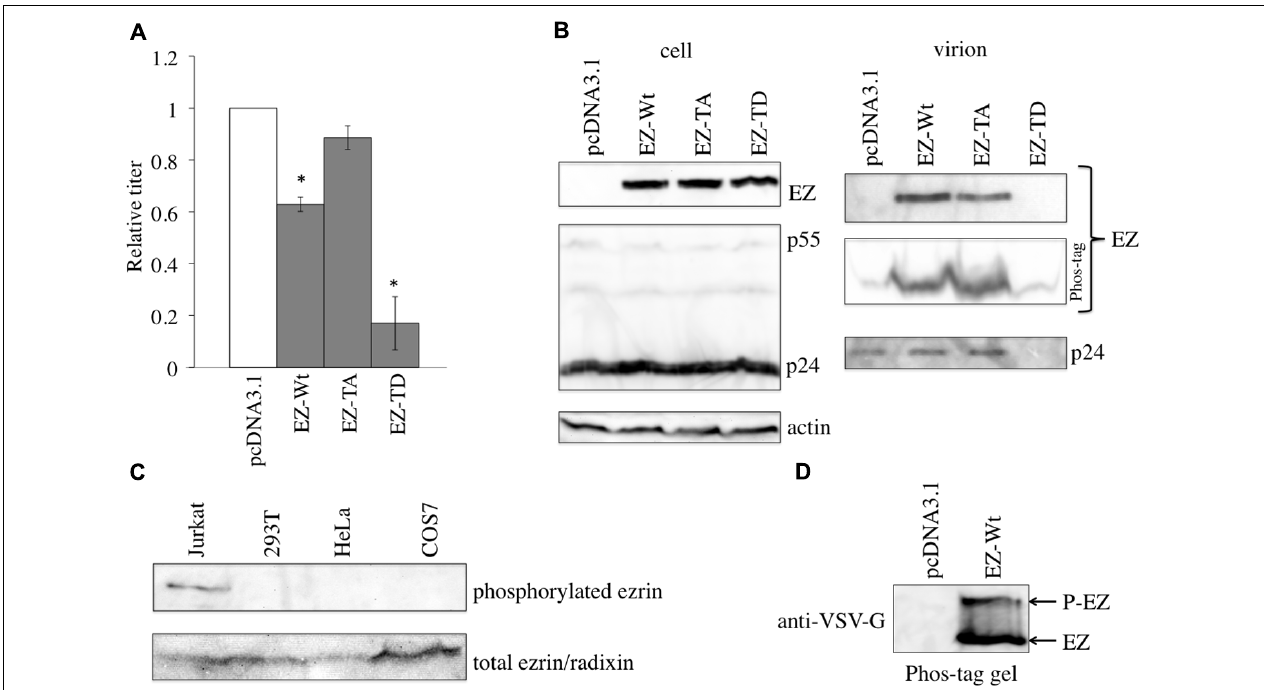
FIGURE 4 | EZ-TD inhibits HIV-1 vector release. (A) COS7 cells were transfected with the HIV-1 vector construction plasmids together with pcDNA3.1, EZ-Wt, EZ-TA, or EZ-TD expression plasmid, and culture supernatants from the transfected cells were inoculated onto HeLa/CD4 cells. Transduction titers of pcDNA3.1-transfected cells were always set to 1, and relative values of transduction titers of other transfected cells are indicated. Error bars show standard deviations, and asterisks indicate statistically significant differences compared to pcDNA3.1-transfected cells. (B) Cell lysates (left panels) and virion pellets of culture supernatants from the transfected cells (right panels) were analyzed by western immunoblotting using the anti-VSV-G epitope, anti-HIV-1 p24, or anti-actin antibody. Virion pellets were also separated on Phos-tag reagent-containing gels. (C) Cell lysates from Jurkat, 293T, HeLa, and COS7 cells were analyzed by western immunoblotting using the anti–phosphorylated-ezrin (upper panel) or anti-ezrin (lower panel) antibody. (D) Cell lysate from Jurkat cells transfected by the EZ-TD expression plasmid were applied to Phos-Tag reagent-containing gel, and then analyzed by western blotting using the anti-VSV-G epitope antibody.